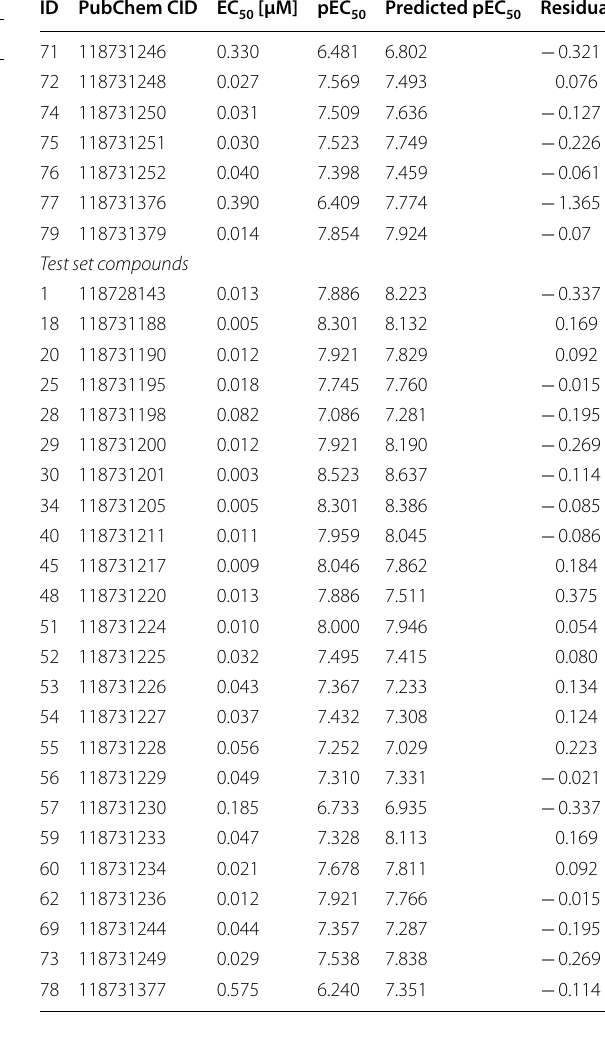
Table 3 The PubChem compound ID (CID), EC predicted pEC , and residual of the entire datasets 50